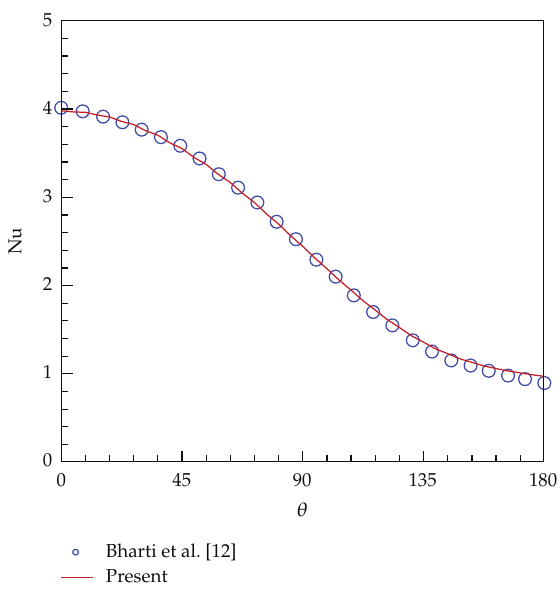
Figure 2: Local Nusselt number distribution on the surface of cylinder at Re (cid:9) 20.